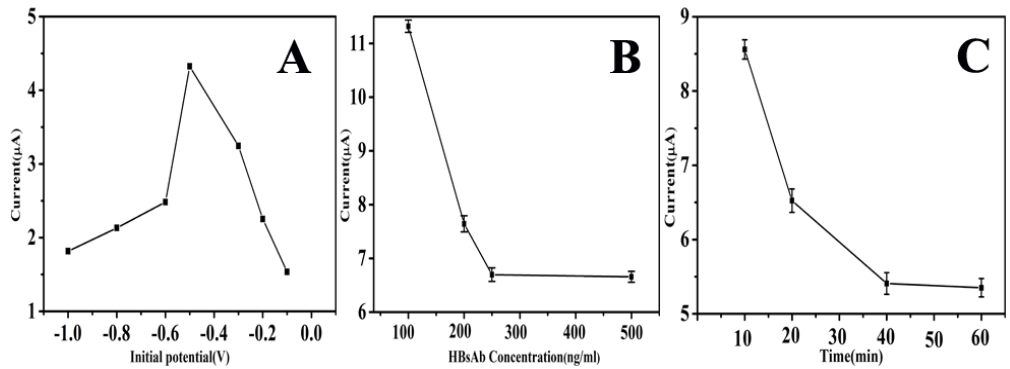
Figure 6. Effect of working potential on the electrodeposition of HAuCl 4 ( A ); and effects of concentration of HBsAb ( B ) and incubation time ( C ) on the detection of HBsAg.